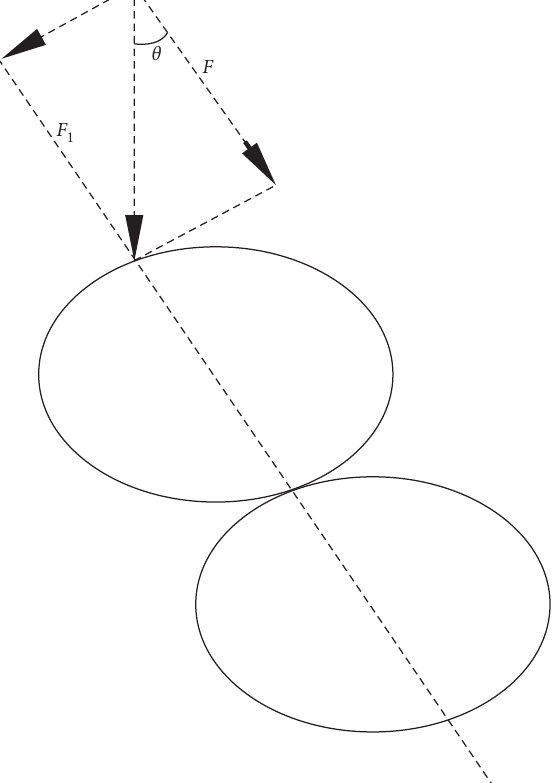
Figure 3: Stress analysis of a force